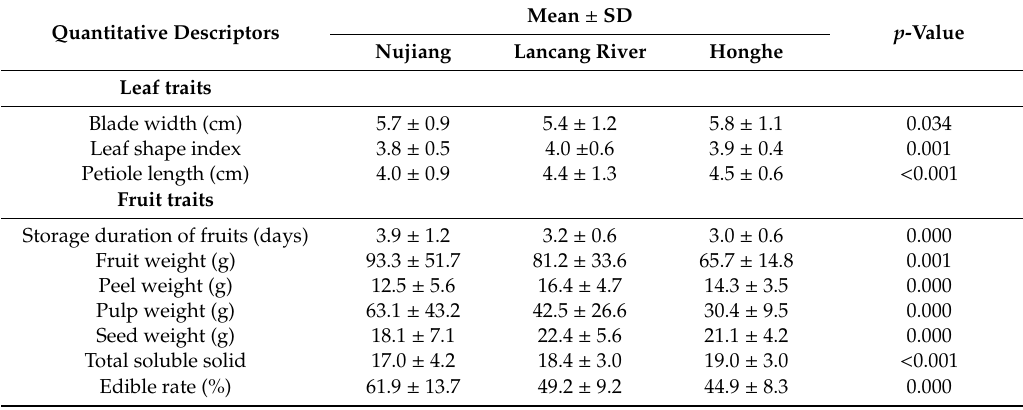
Table 3. Comparison of the performance of the studied mango germplasm among the three regions of collection using the quantitative descriptors.